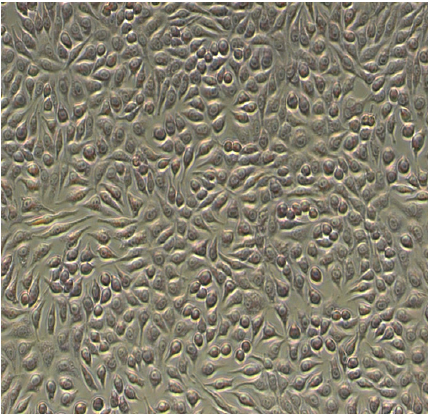
Figure 4. NCTC control, 72 h.